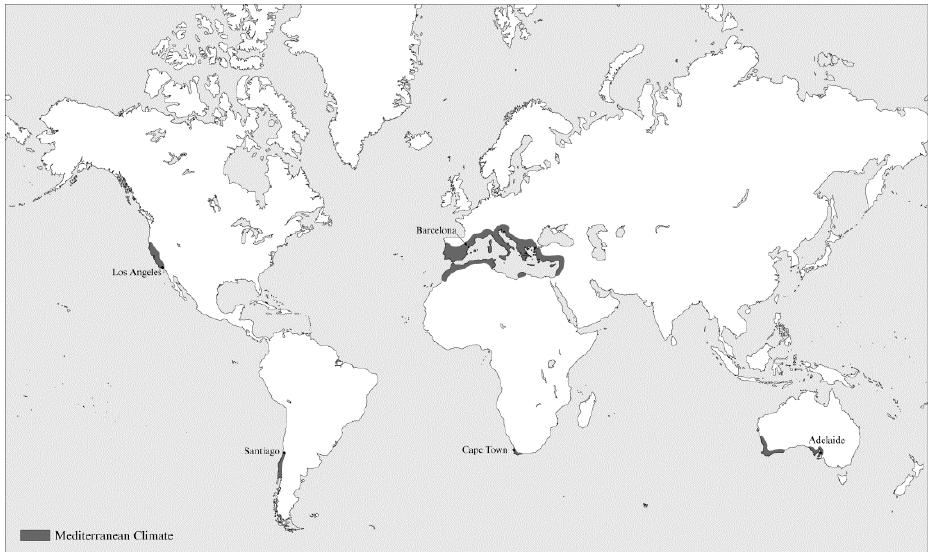
Figure 1. Location of Mediterranean climates and the five Med-cities in the current study.